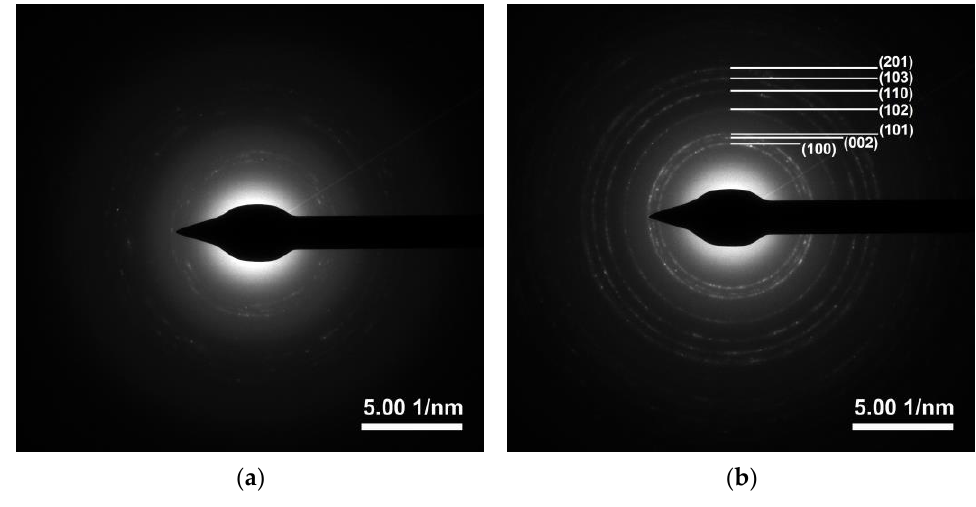
Figure 6. SAED patterns of ( a ) ZnO and ( b ) Ti-ZnO NPs.